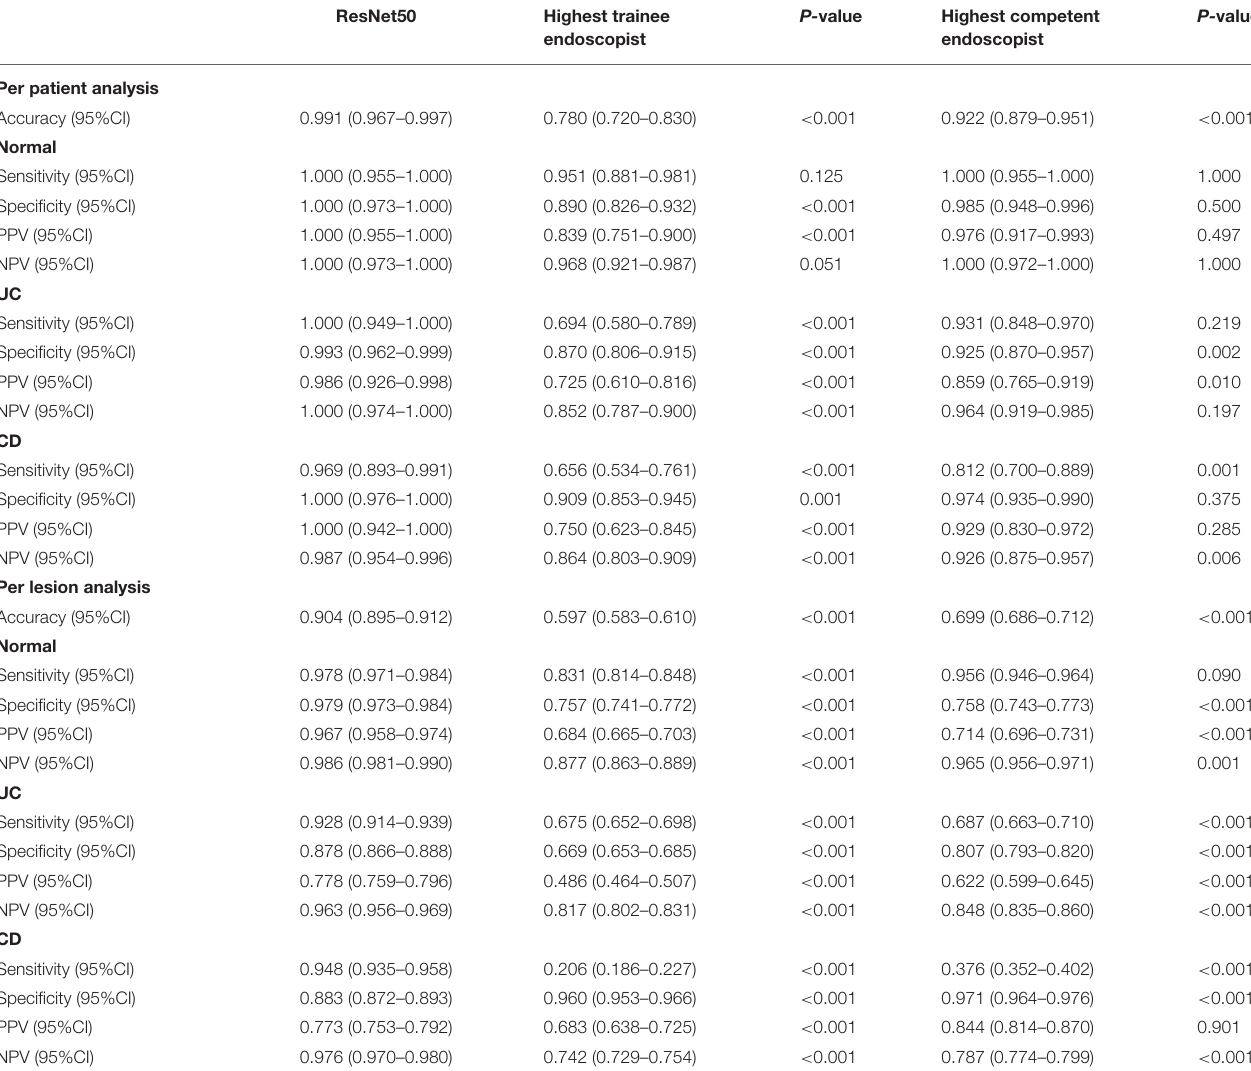
TABLE 2 | Comparison of classification performance between deep model and endoscopy doctors (per patient and per